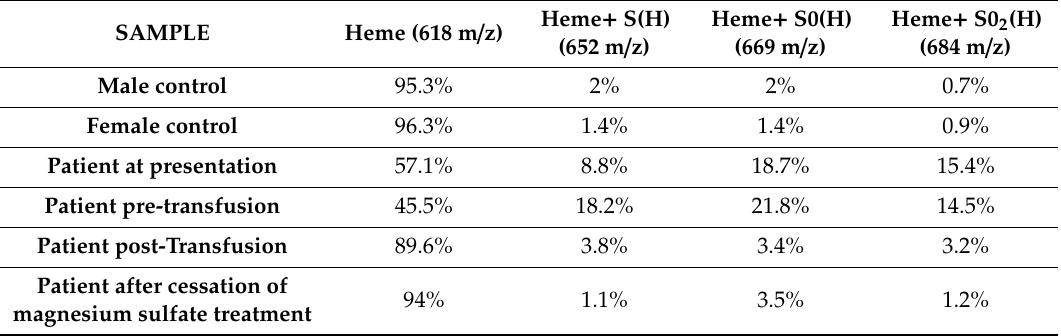
Table 1. Percentage of heme and sulfated adducts in blood